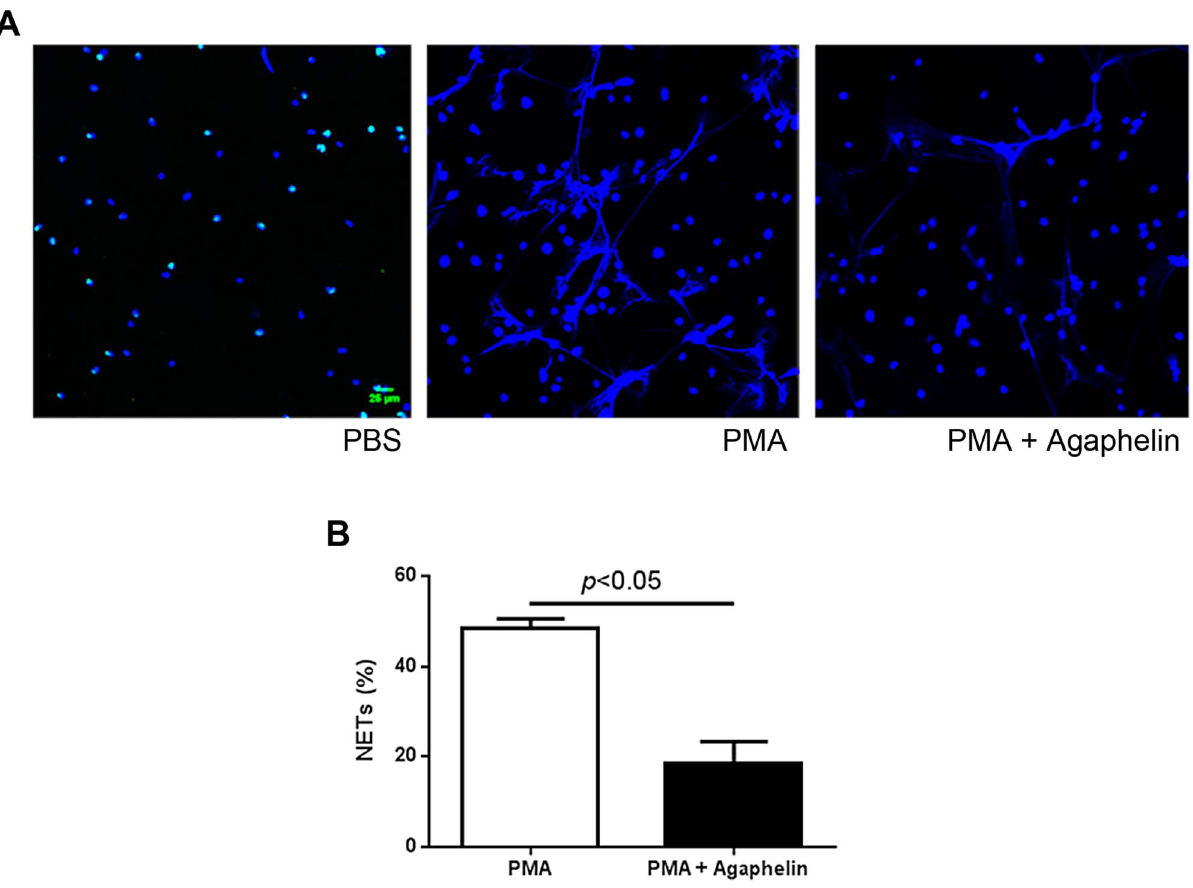
Figure 5. Agaphelin inhibits NETs formation. (A) Adherent neutrophils were incubated with Agaphelin or PBS (control) for 1 hour, and activated with PMA (5 nM, central panel), or PMA plus Agaphelin (right panel) for 3 h at 37 u C. Left panel, non-activated neutrophil (no PMA). Formation of NETs was visualized under confocal microscopy, using antibody against citrullinated histone. Representative experiment is shown (4 different donors). B) Quantification. Performed as described in Methods. Sixty five per cent inhibition of NETs formation was attained with 1 m M Agaphelin ( p =0.03, t - test).